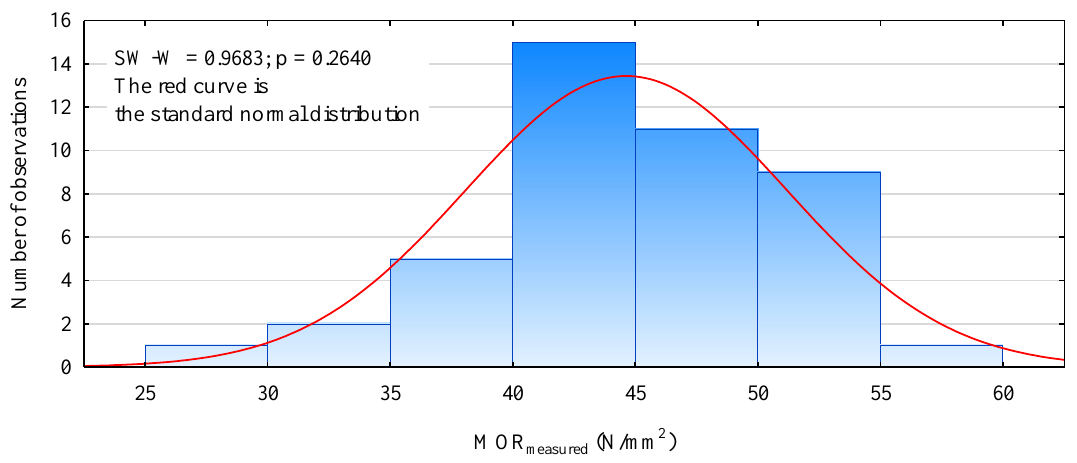
24.4 Figure 6. Characteristic values of the static bending strength for the prepared beam (samples). The numbers in blue denote the 5-percentile value. It is hard to predict the exact point of failure and the potential strength in some cases. For Beam 41 (Figure 7a), the cause of destruction was found, as expected, in the second and third lamellas and was due to the presence of large rotten knots in the pure bending zone. On the other hand, the beam